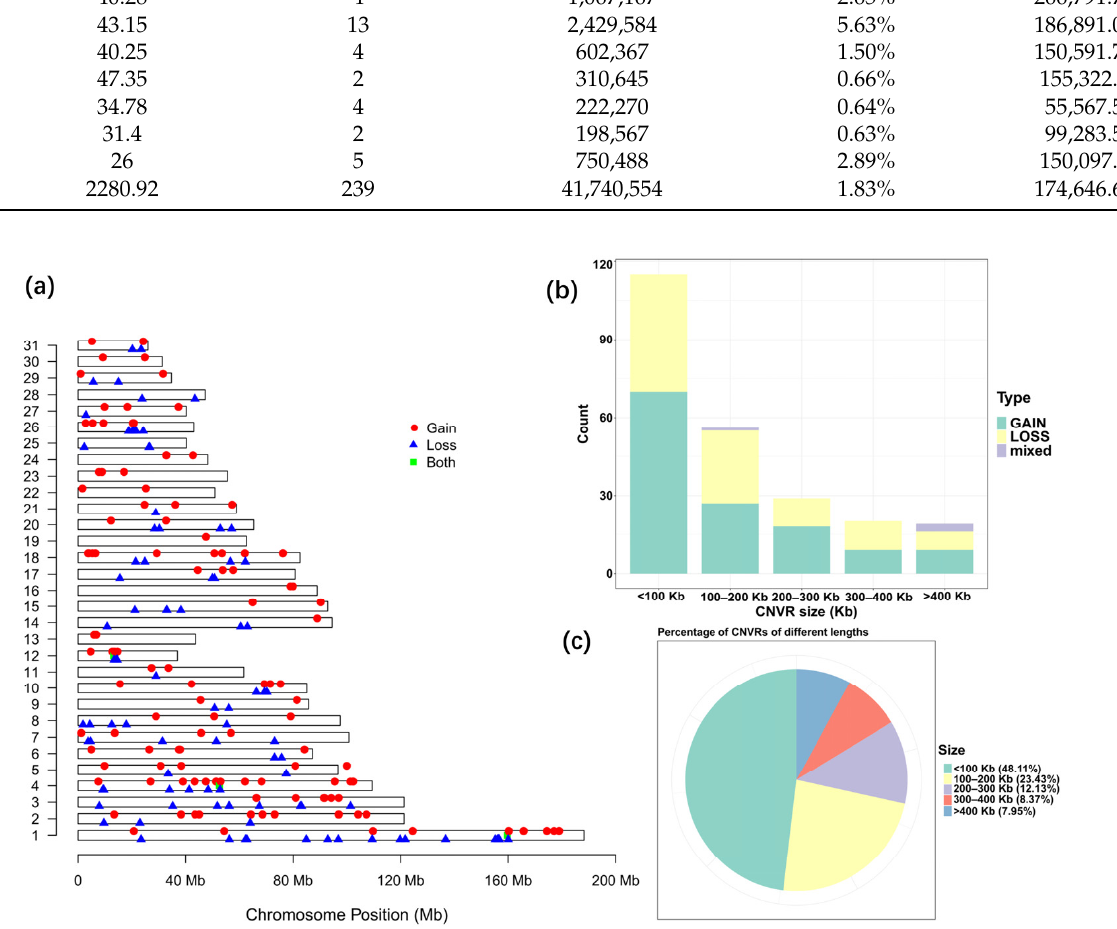
Figure 2. Statistics of CNVRs on equine autosomes. ( a ) Map of CNVRs in the horse genome. Red, blue and green represent gain, loss and both (gain and loss), respectively. ( b ) Size range distribution of the CNVRs detected. ( c ) Scale distribution of the CNVRs detected.